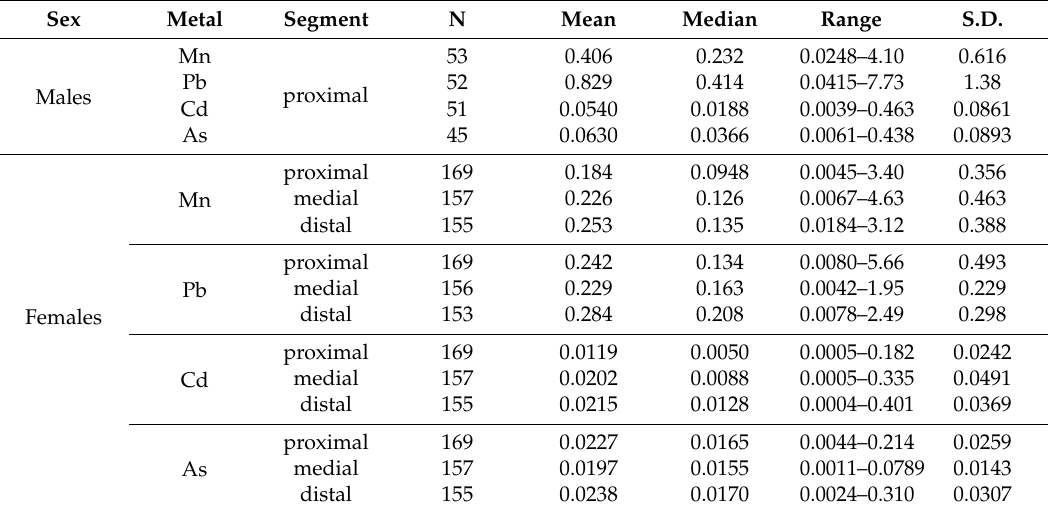
Table 1. Hair metal concentrations ( µ g metal/g hair) of two centimeter hair segments from males and females